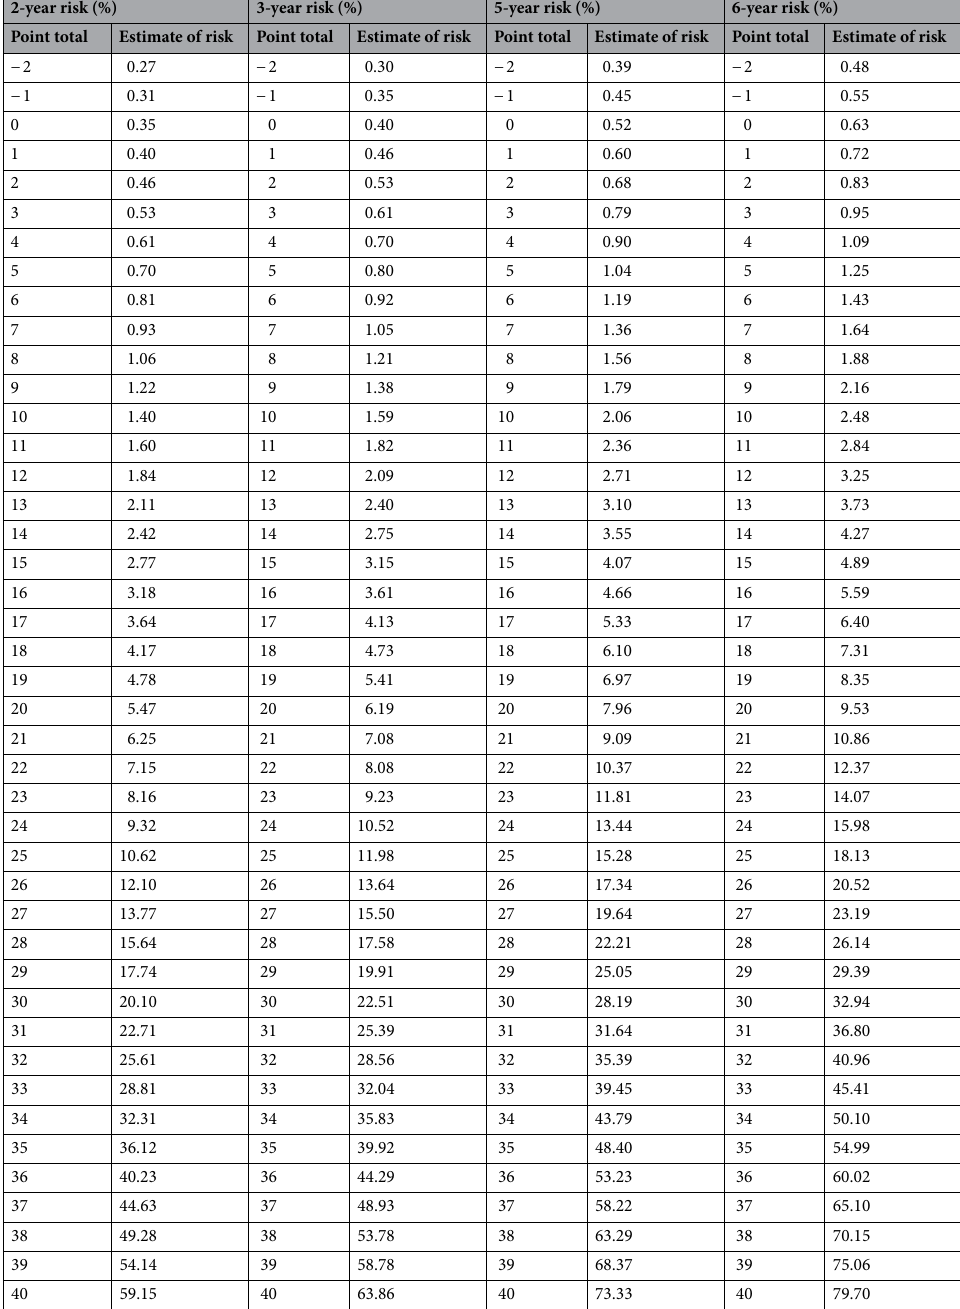
Table 5. Risk estimates for point totals at 2, 3, 5, and 6-year time. We determine the risks that are associated with each point in total. The first step is to select the point totals’ theoretical range based on the point system computed earlier. In our point system, the theoretical range of point totals is − 2 to 40. We then attached a risk estimate to each point total using the Cox regression equation.